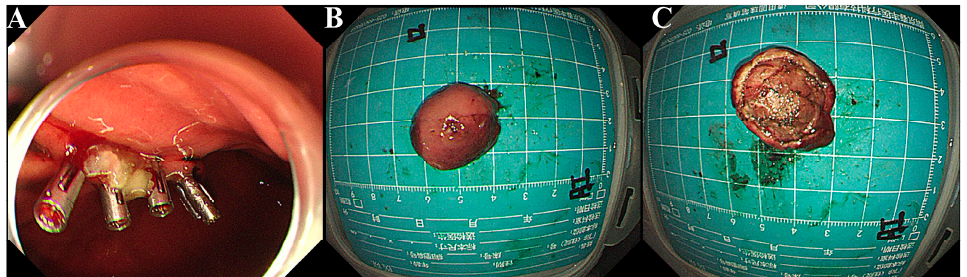
Figure 3. ESE and gross features of the mass. ( A ) After ESE’s en bloc excavation, four clips were used to close the incision. ( B , C ). Grossly, the mass was yellowish pink with a pink-gray cut